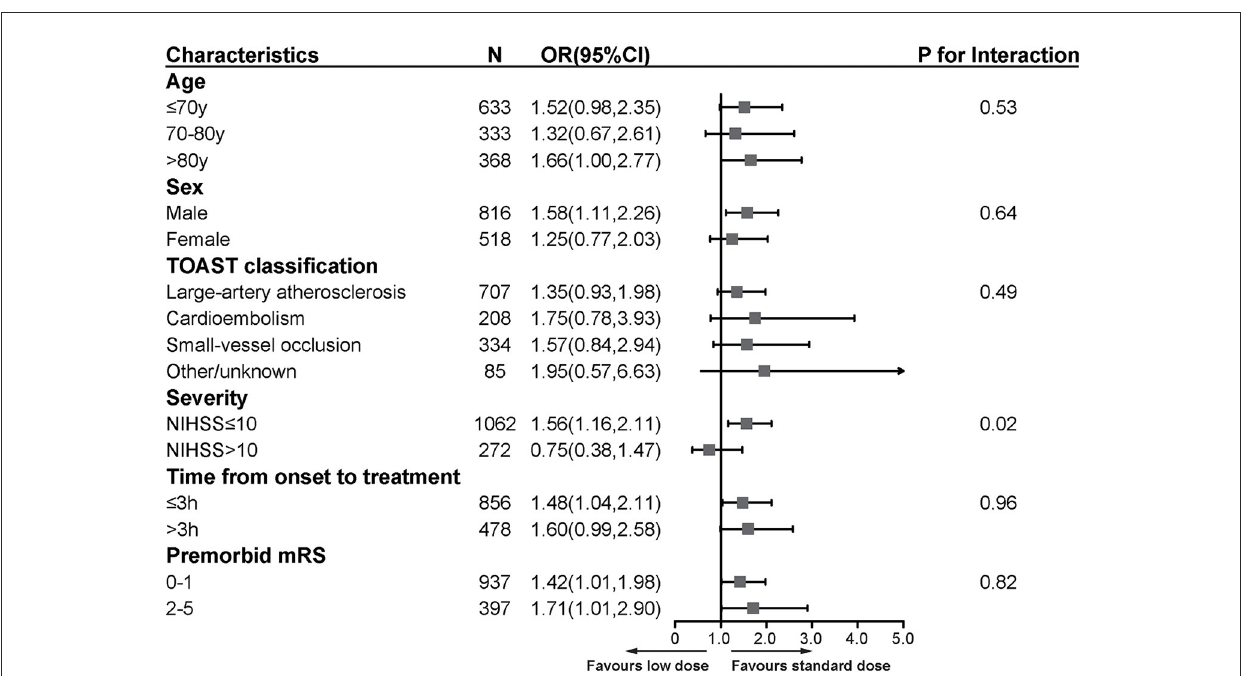
FIGURE3 Subgroup analyses of primary functional outcome between low-dose and standard-dose group in propensity score matching dataset. The forest plot shows the difference in the primary functional outcome across all subgroups. The primary functional outcome was death or disability at discharge, defined by scores of 2 to 6 on the mRS [range, 0 (no symptoms) to 6 (death)]. The OR was calculated by using logistic regression, taking the following variables into account: age, sex, medical history (ischemic stroke, hypertension disease, diabetes, dyslipidemia, atrial fibrillation, myocardial infarction), baseline NIHSS, time from onset to treatment, premorbid score and TOAST classification. NIHSS, National Institutes of Health Stroke Scale [range, 0–42 (most severe)]; mRS, modified Rankin scale [range, 0–6 (most severe)]; OR, odds